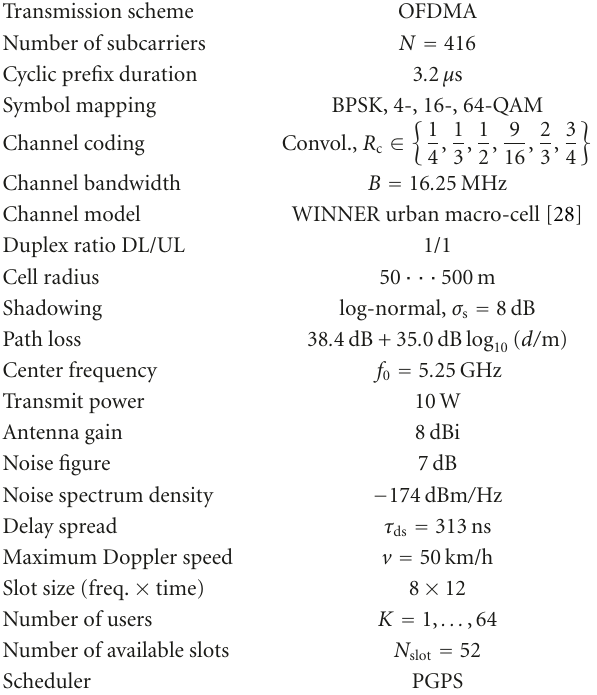
Table 2: Link layer